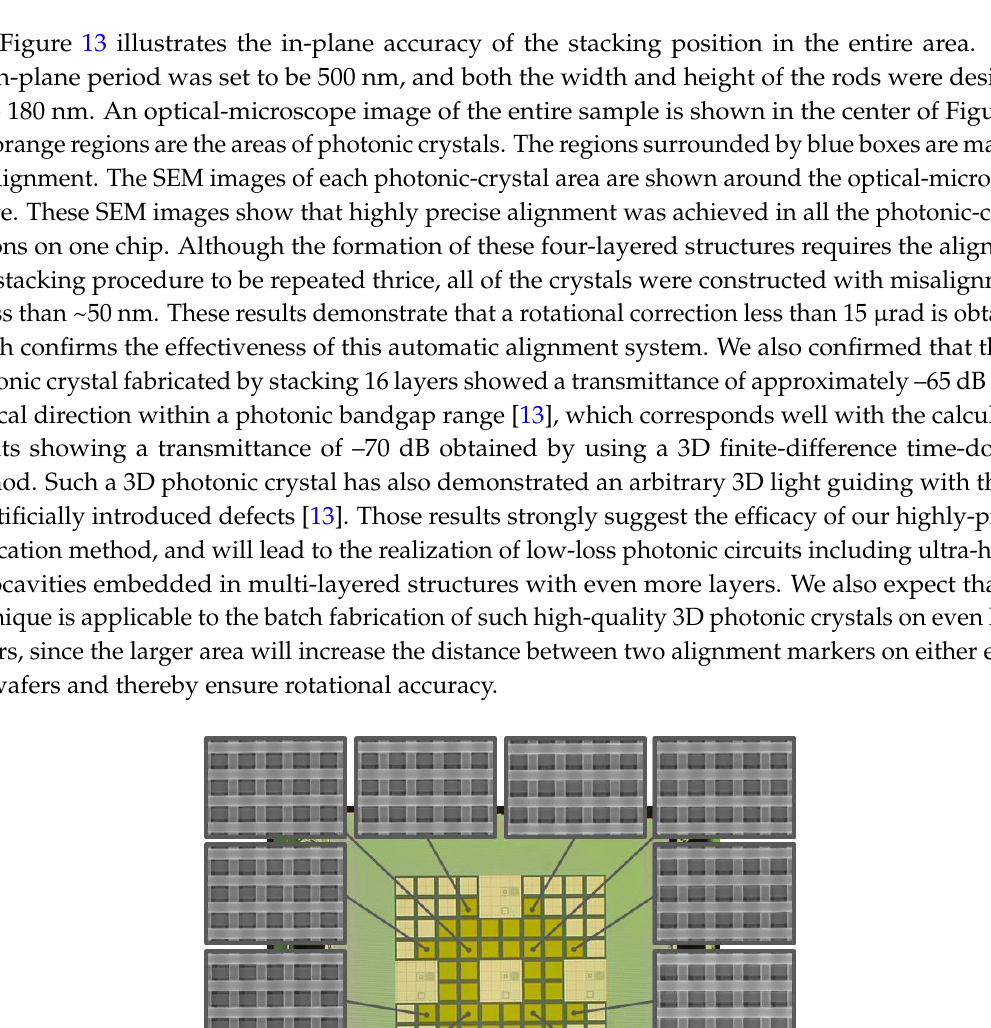
Figure 13. Optical microscope image of whole sample and SEM image of each 3D photonic crystal.